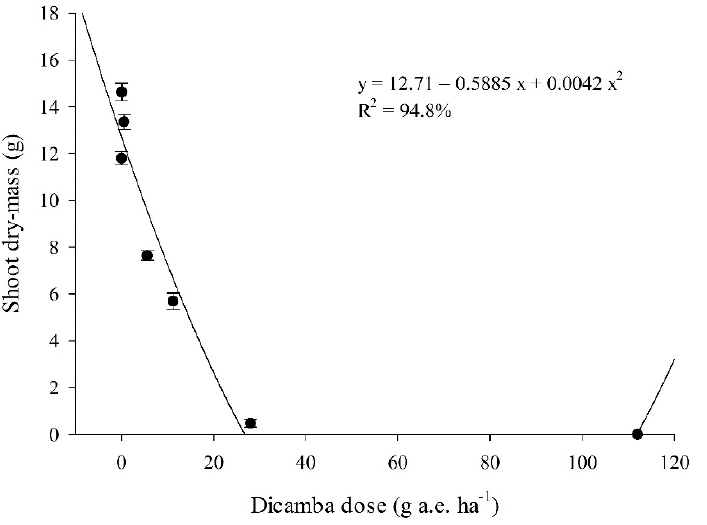
Figure 5. Soybean shoot mass (g) for different doses of dicamba at 99 days after soybean sowing. Error lines in each point denote standard deviation.